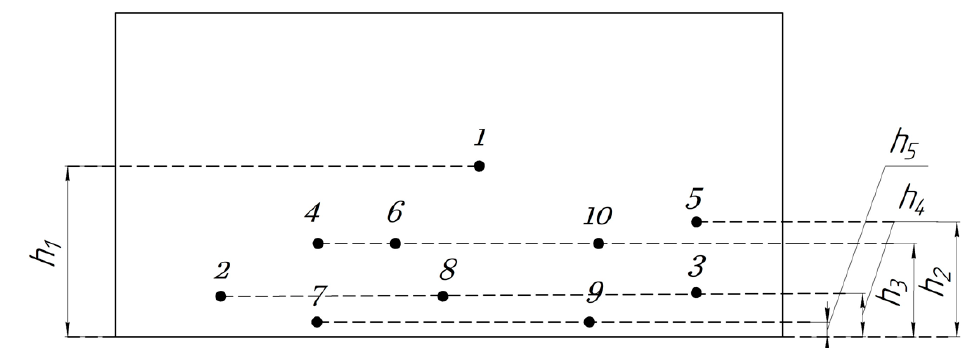
Figure 2. Selected points for data array calculating and collecting.